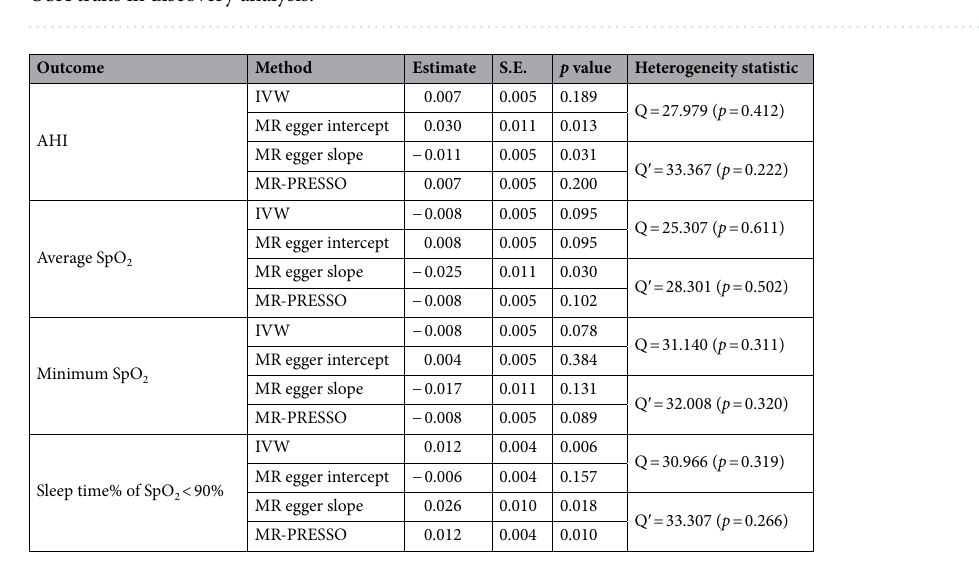
Table 2. MR sensitivity analysis between Reactome heme biosynthesis pathway and OSA traits.